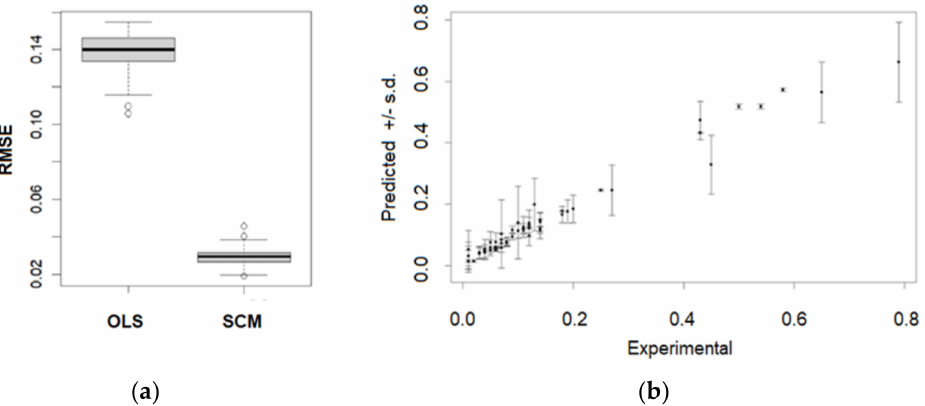
Figure 3. ( a ) Predictions of LPMO dye decolorization efficiency by the linear ordinary least squares OLS model, and ( b ) the structural causal model